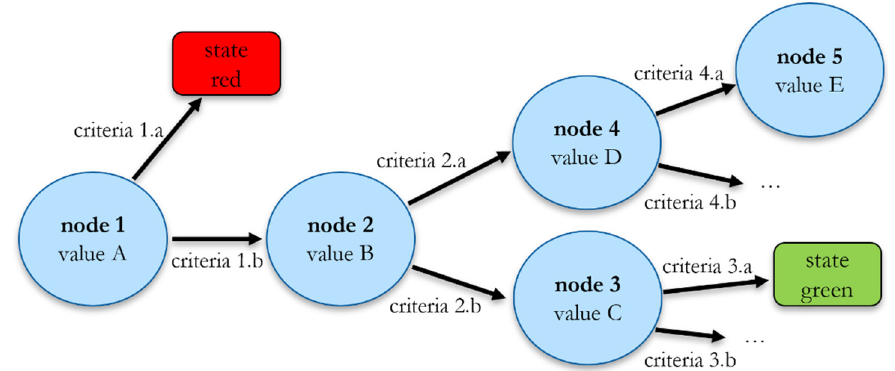
Figure 7. App “BatteryCheck”—assessment principle of BMS data with a decision tree: every node corresponds to a certain CAN-signal, which was received from the BMS and decoded by the appli-